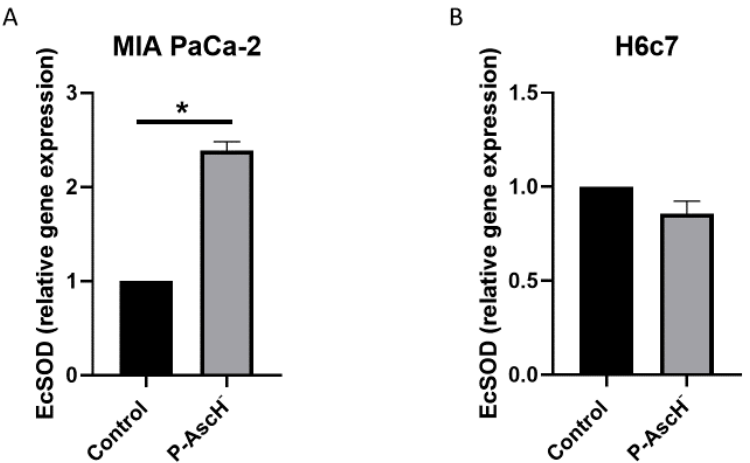
Figure 5. P-AscH - increases EcSOD expression in PDAC. ( A ) MIA PaCa-2 cells were treated with P-AscH − (10 pmole/cell, 1 mM for 1 h). Expression of EcSOD mRNA determined by quantitative real- time RT-PCR 48 h after P-AscH − treatment. MIA PaCa-2 cells treated with P-AscH − had increased expression relative to control and normalized to 18s expression, * p < 0.01, n = 3. Two-tailed Student’s t-test was performed. ( B ) H6c7 cells showed no difference in EcSOD expression 48 h after P-AscH − treatment (10 pmole/cell, 1 mM for 1 h), p = 0.09, n = 3. Two-tailed Student’s t-test was performed.